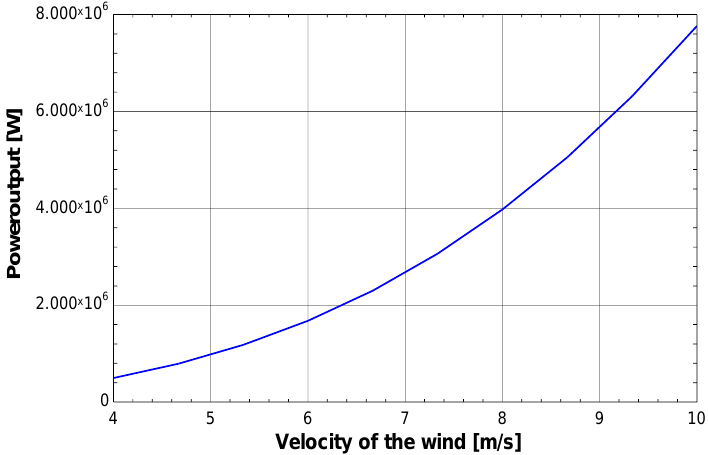
Figure 9. Effect of the velocity of air on wind power.